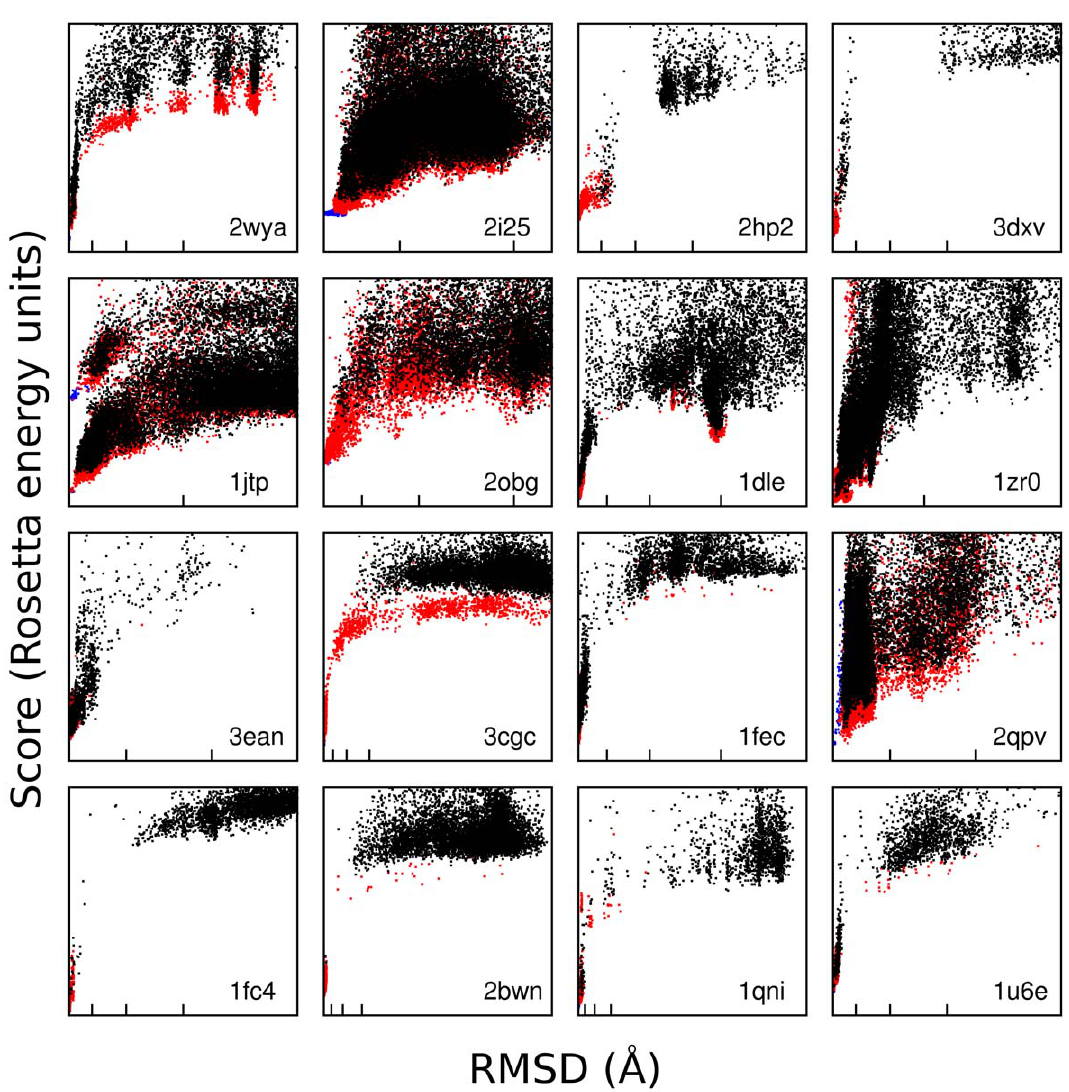
predictions, red points are relaxed native trajectories, and blue points are conservative relaxed native trajectories which skipped the centroid phase (see main text). Blue points may lie under red points, and red points may lie under black points. Some high-score points are out of view on all plots; all low-score points are present. On the RMSD (X) axis, the first, second, and third tic marks represent 1, 2.5, and 5 A˚ngstroms. Some plots are zoomed in beyond 5 or 2.5 A˚ngstroms and fewer tics